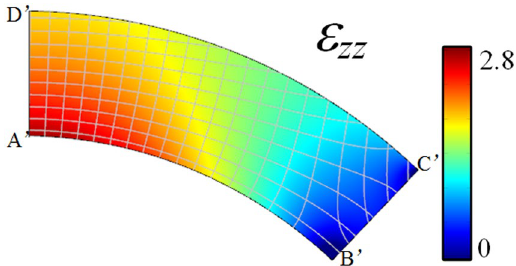
Figure 2. The calculated permittivity ( ε zz ) distribution varies from 0 to 2.8.